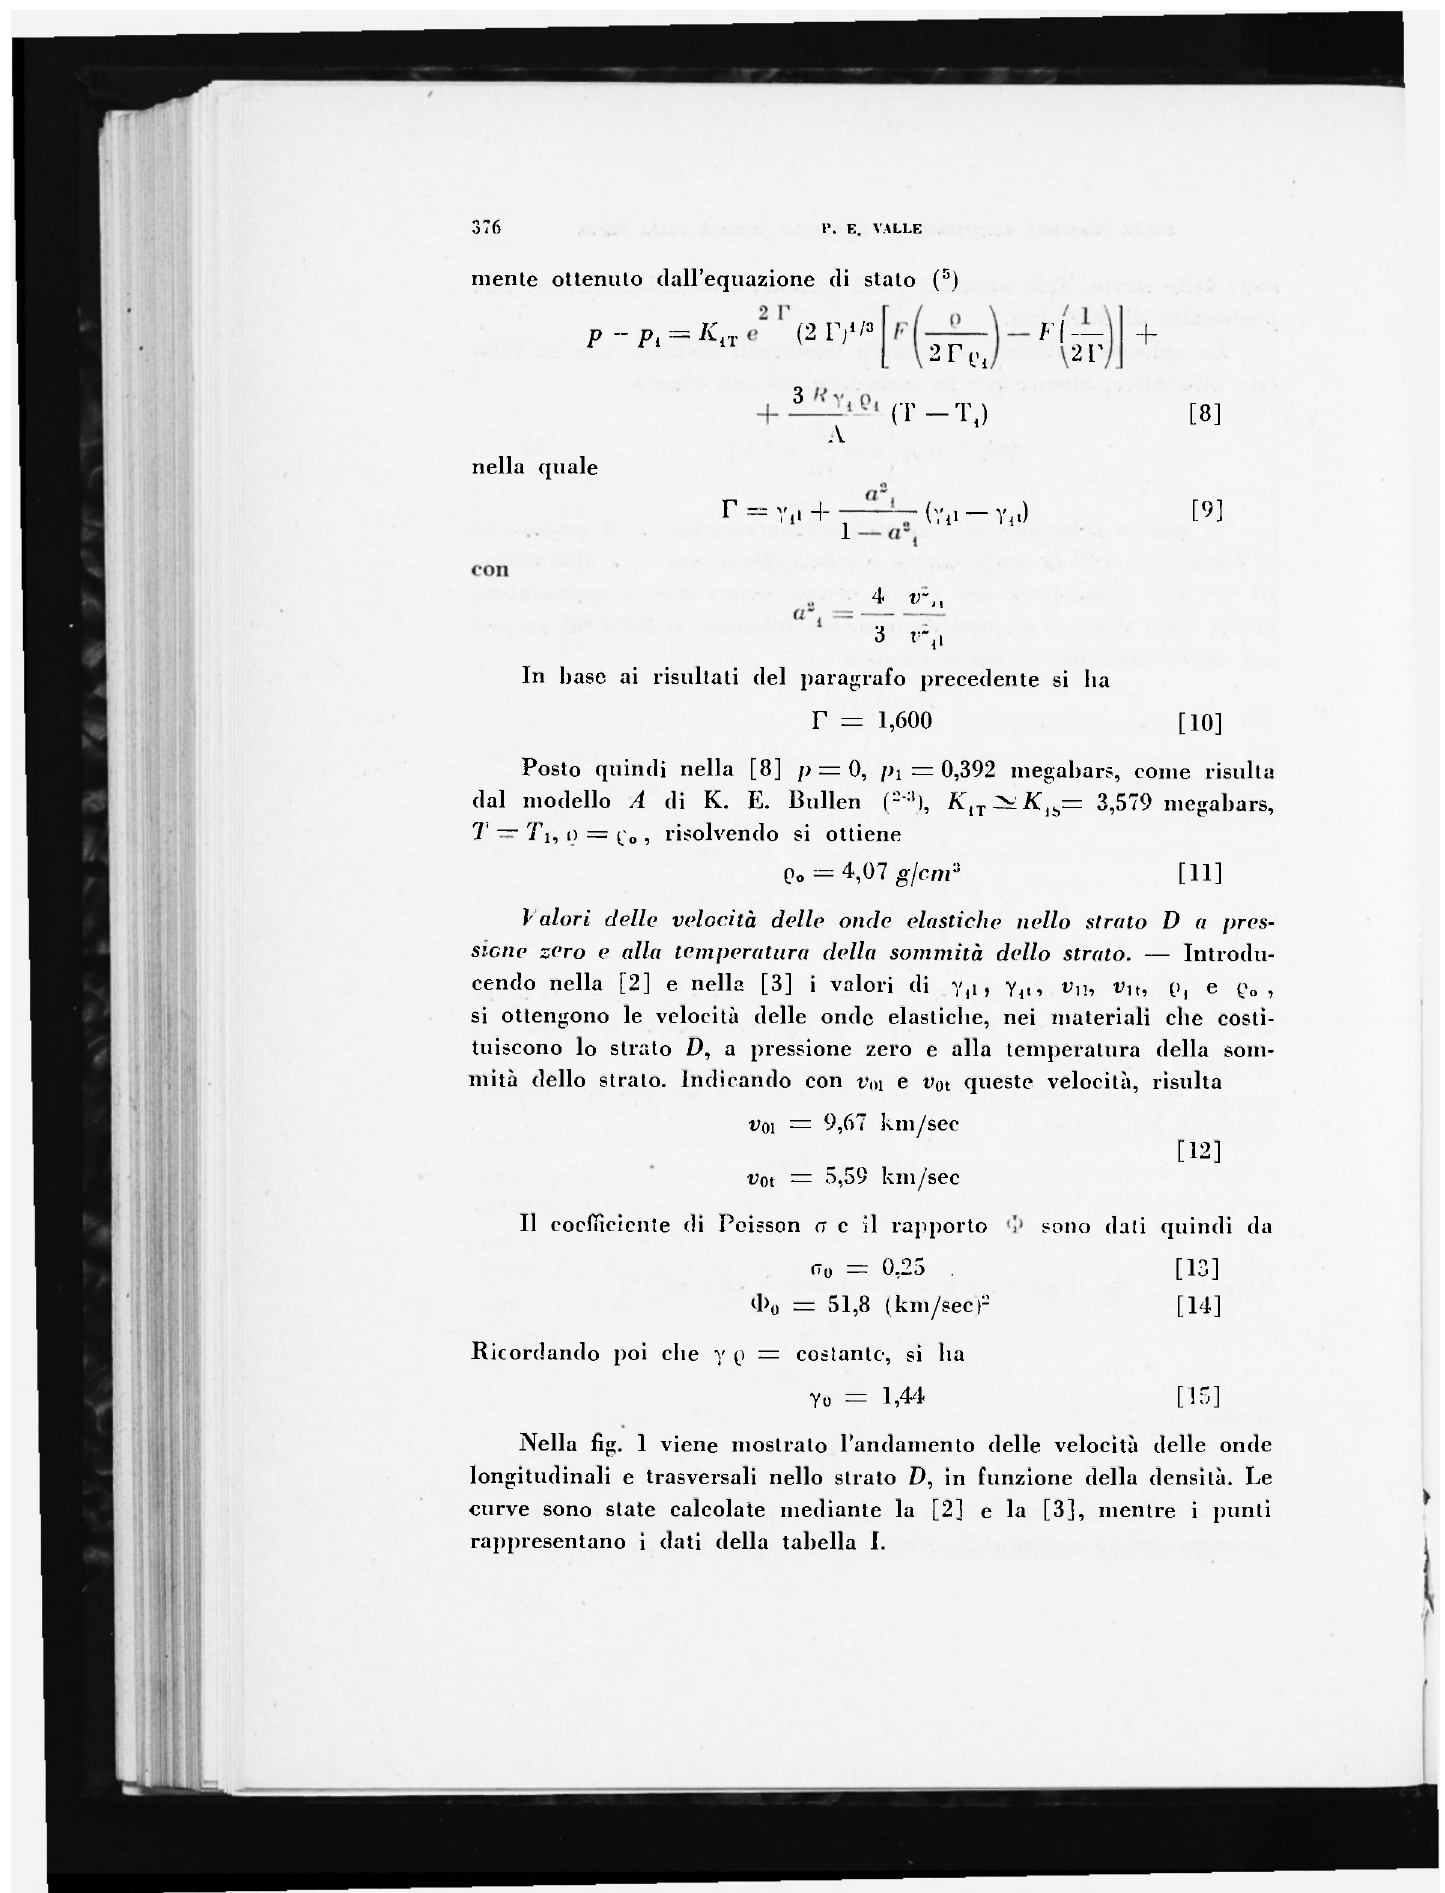
Nella fig. 1 viene mostrato l'andamento delle velocità delle onde longitudinali e trasversali nello strato D, in funzione della densità. Le curve sono state calcolate mediante la [2] e la [3], mentre i punti rappresentano i dati della tabella